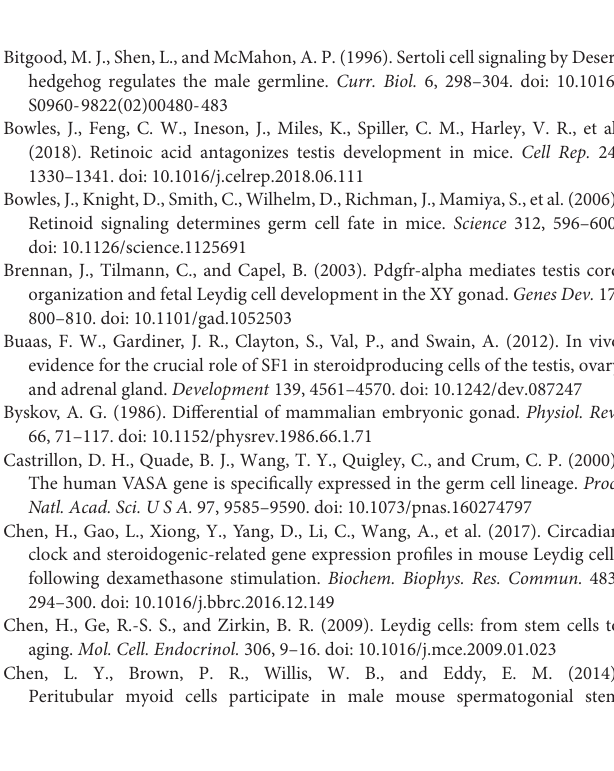
Supplementary Figure 1 | (A,A (cid:48) ) Scatter plot showing the selection of Leydig cells (GFP+++) by FACS in E18.5 (A) and in P100 (A (cid:48) ) testis cell suspension. The X -axis corresponds to the GFP florescence level and the Y -axis forward scatter area explaining the granularity of the events. (B) Heatmap showing the normalized scaled expression of selected marker genes in our three replicates at E18.5 (pale green) and in our three replicates at P100 (dark green). The color is representative of the expression level. The gene expression confirmed the purity of the samples in Leydig cells. Cyp11a1, Star, Nr5a1, Hsd3b1, Insl3, Cyp17a1, Hsd17b3 , and eGFP : Leydig cells. Cdh5, Pecam1, Acta2 , and Rgs5 : Endothelial cells. Pdgfra, Tcf21, Wnt5a , and Nr2f2 : Interstitial progenitors. Amh, Lhx9, Dhh , and Sox9 : Sertoli cells. Pou5f1, Mael, Dadx4 , and Dazl : Germ cells. (C) Heatmap showing the Spearman correlation score between the six Leydig cells samples. The score is indicated by the color scale. (D) Principal Component Analysis (PCA) plot where each dot corresponds to a Leydig cells sample. The dots are colored according to the sample type. E18.5: pale green; P100: dark green. Supplementary Figure 2 | Immuno-histochemistry (IHC) staining on mouse fetal and adult testis. The DNA is colored in white, HSD3B labels Leydig cells in green and BHMT is colored in red. The white scale bar corresponds to 50 µ